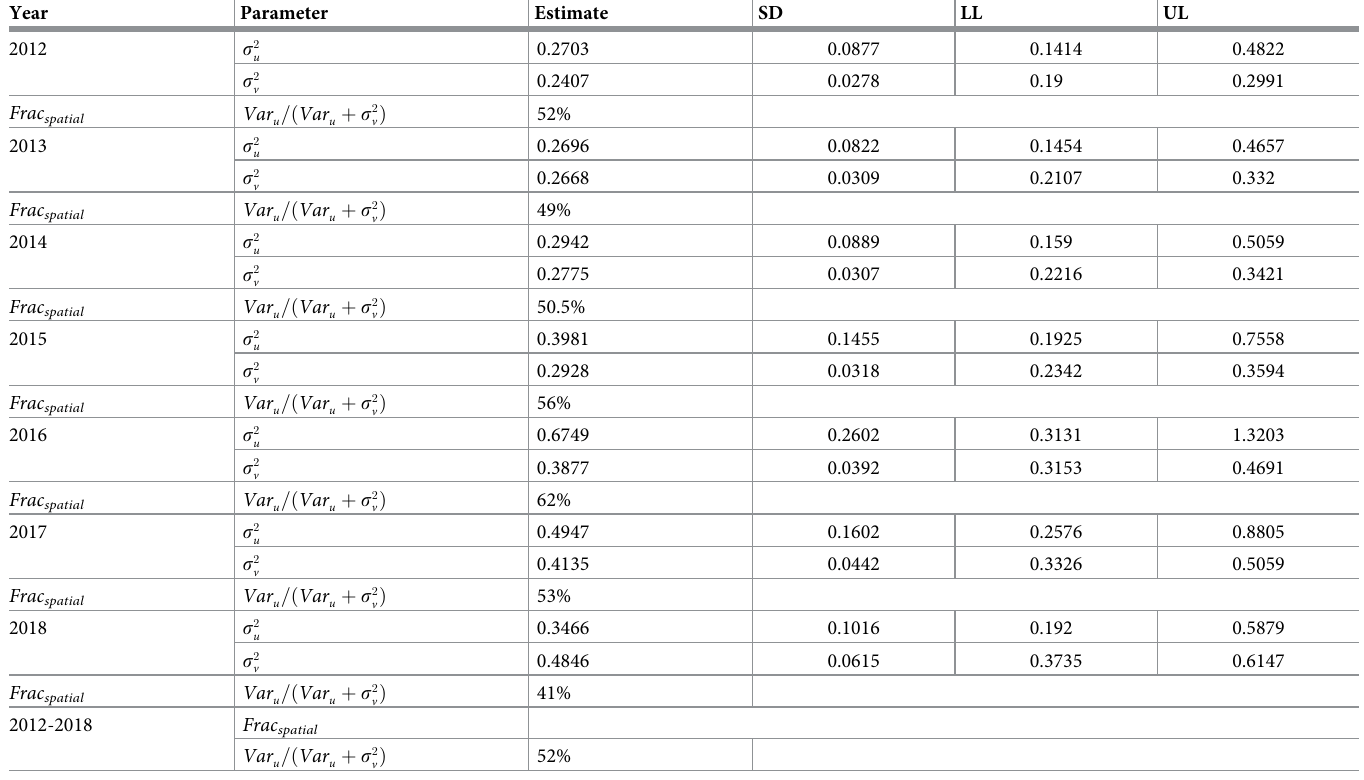
Table 3. Posterior mean and 95% Credibility interval for fixed effect of α